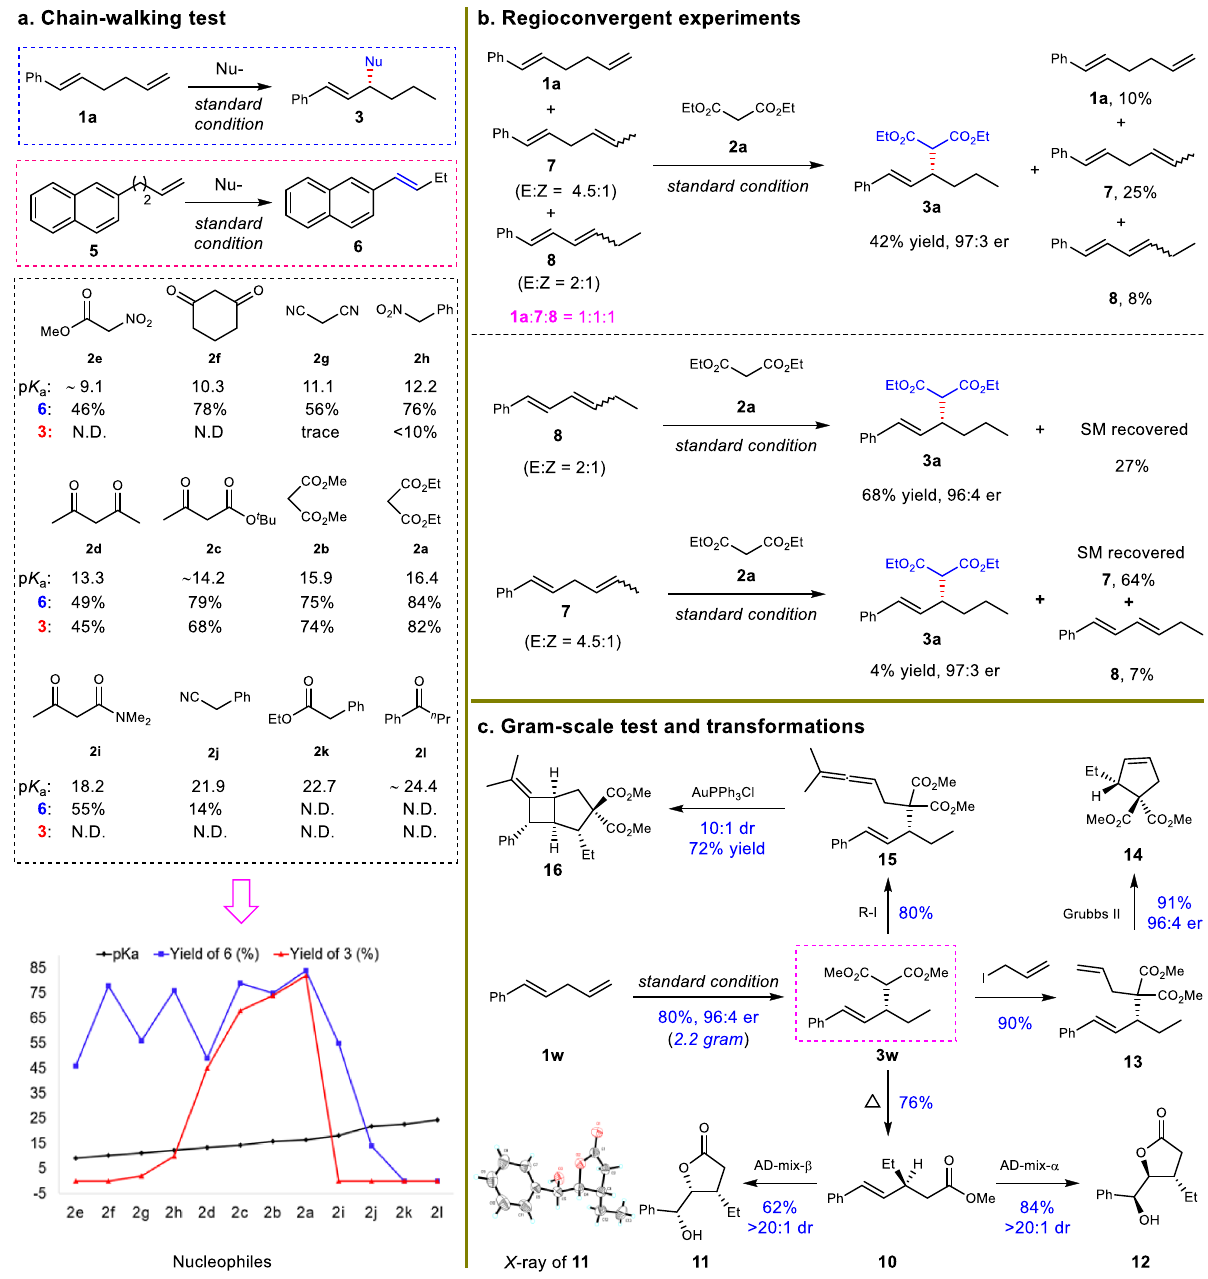
Fig. 4 Scope of nucleophiles and applications. a Chain-walking test of nucleophiles. The blue color of the curve represents the yield of compound 6 . The red color of the curve represents the yield of compound 3 . The black color of the curve represents the pKa value of corresponding nucleophiles used. p K a values in DMSO were shown. N.D. not detected. b Regioconvergent experiments. c Gram-scale test and synthetic